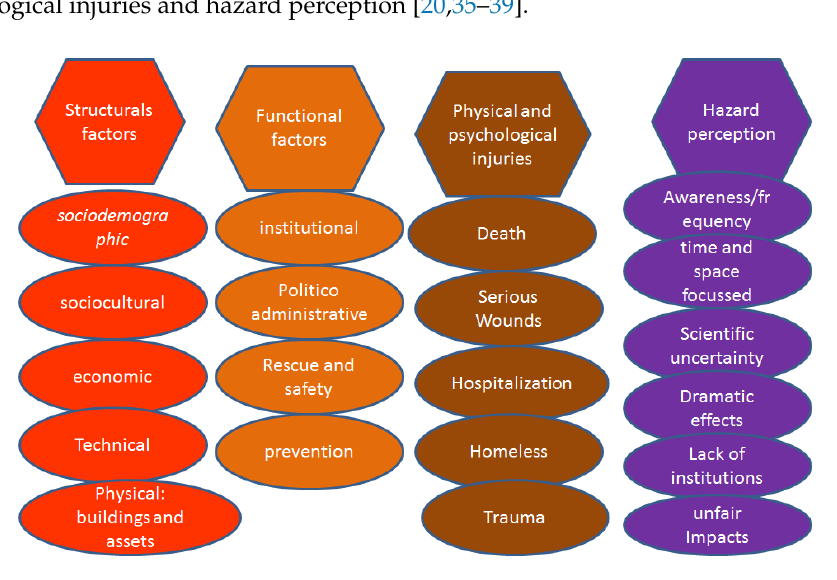
Figure 7. Vulnerability framework. The diagram gives broad detail on the sub components of each vulnerability parameter to be measured.